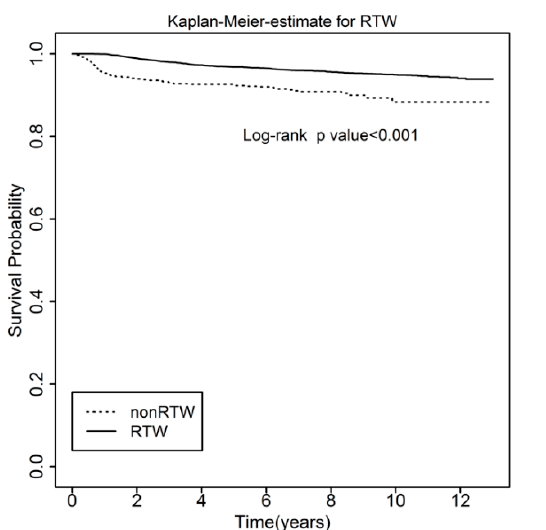
Figure 1. Kaplan-Meier curve for all-cause mortality in the workers with all stages of cervical cancer.